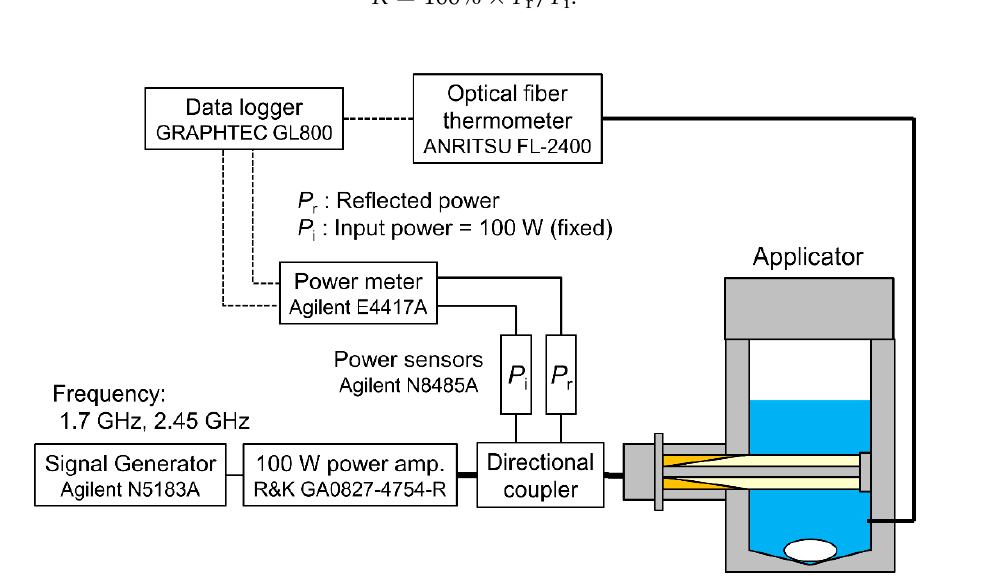
Figure 4. Diagram of the microwave heating measurement system.